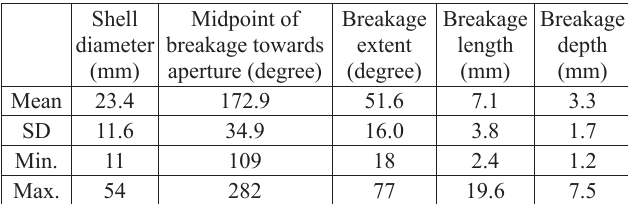
Table 2. Characteristics of ventral breakage of the early Toarcian am- monoid specimens from the Nishinakayama Formation; SD, standard